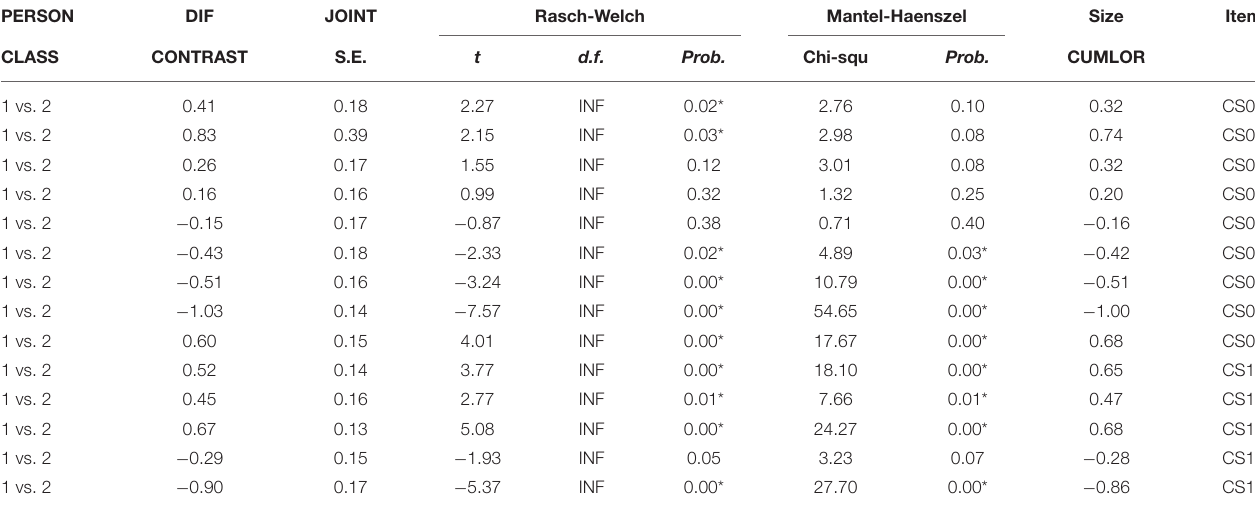
TABLE 5 | Differential item functioning (DIF = gender). PERSON DIF JOINT Rasch-Welch Mantel-Haenszel Size